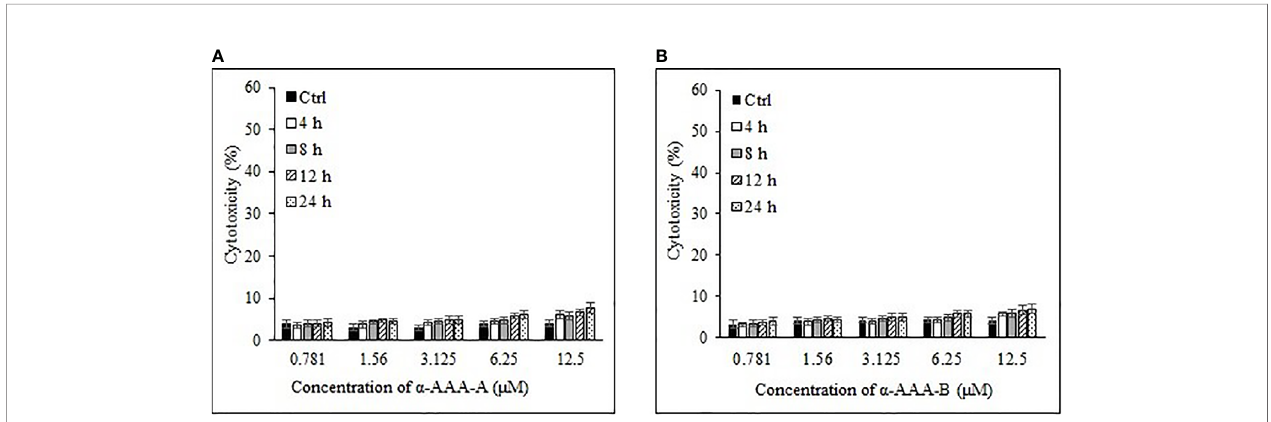
FIGURE 4 | Cytotoxicities of freshly isolated PBMCs cytotoxicities by a -AAA-A (A) and a -AAA-B (B) at different concentrations and time durations of incubation. PBMCs without molecules served as control.